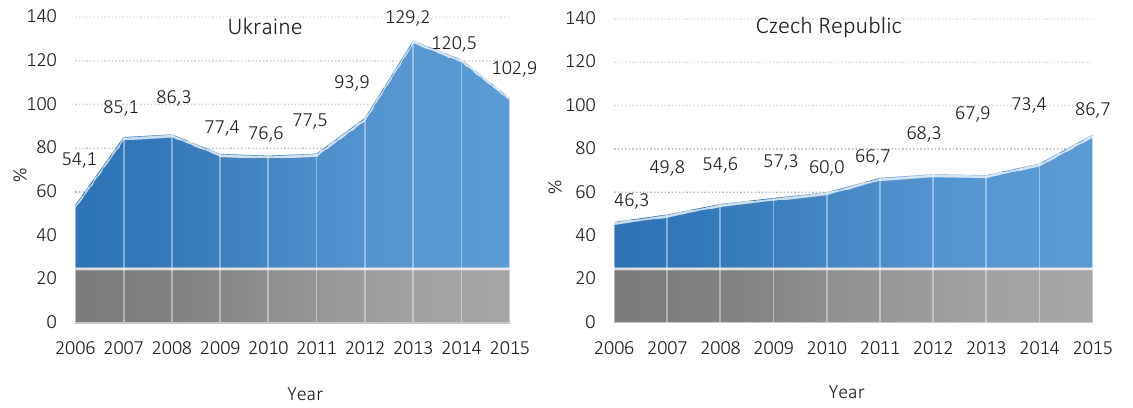
Figure 6. The ratio of external debt in Ukraine and the Czech Republic, % of GDP, 2006–2016